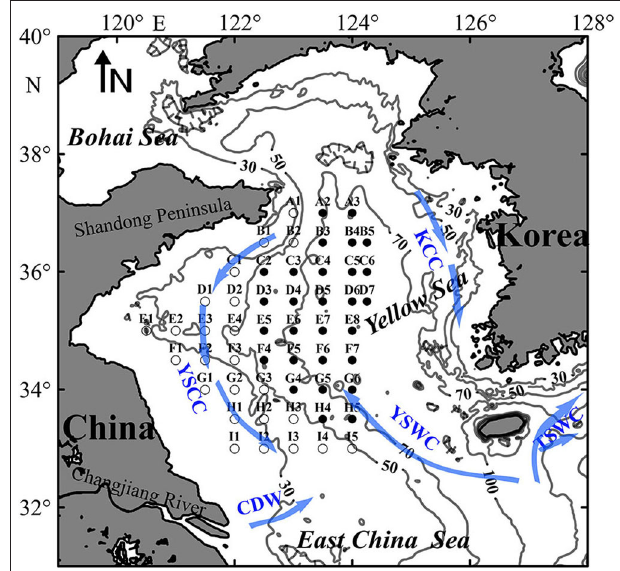
FIGURE 1 | Map of the sampling stations in the Yellow Sea. Open and solid circles represent stations in the shallow and deep regions, respectively. Contour lines indicate water depth (m), and arrows represent circulation regimes, including Yellow Sea Warm Current (YSWC), Yellow Sea Coastal Current (YSCC), Korean Coastal Current (KCC), Changjiang Diluted Water (CDW), and Tsushima Warm Current (TSWC).